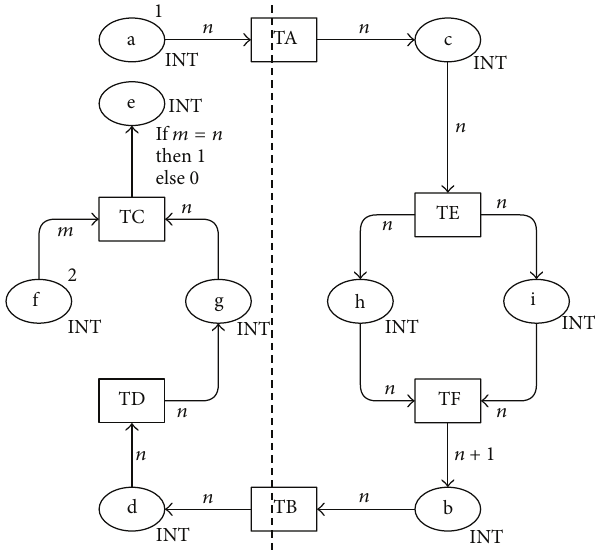
Figure 1: Example of system